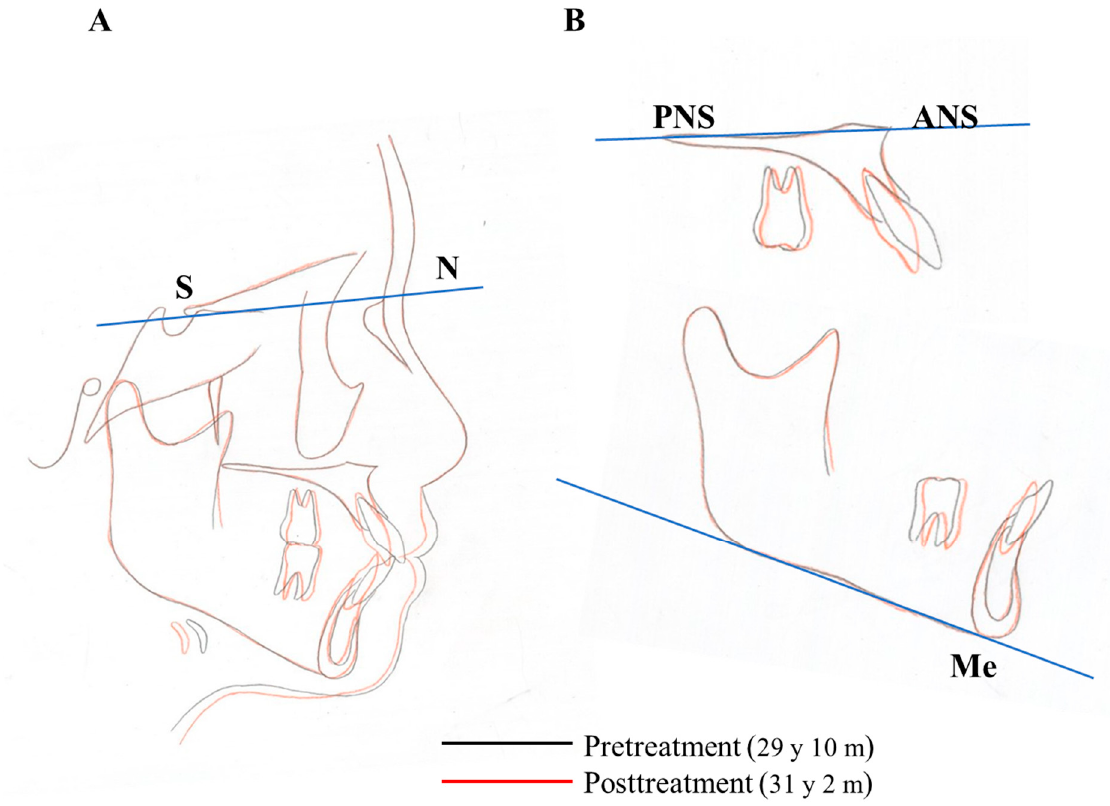
Figure 16. Superimposition of the cephalometric tracings at pretreatment and posttreatment. ( A ), The sella-nasion plane at sella; ( B ), Cephalometric superimpositions. Palatal plane at ANS and Mandibular plane at Me.